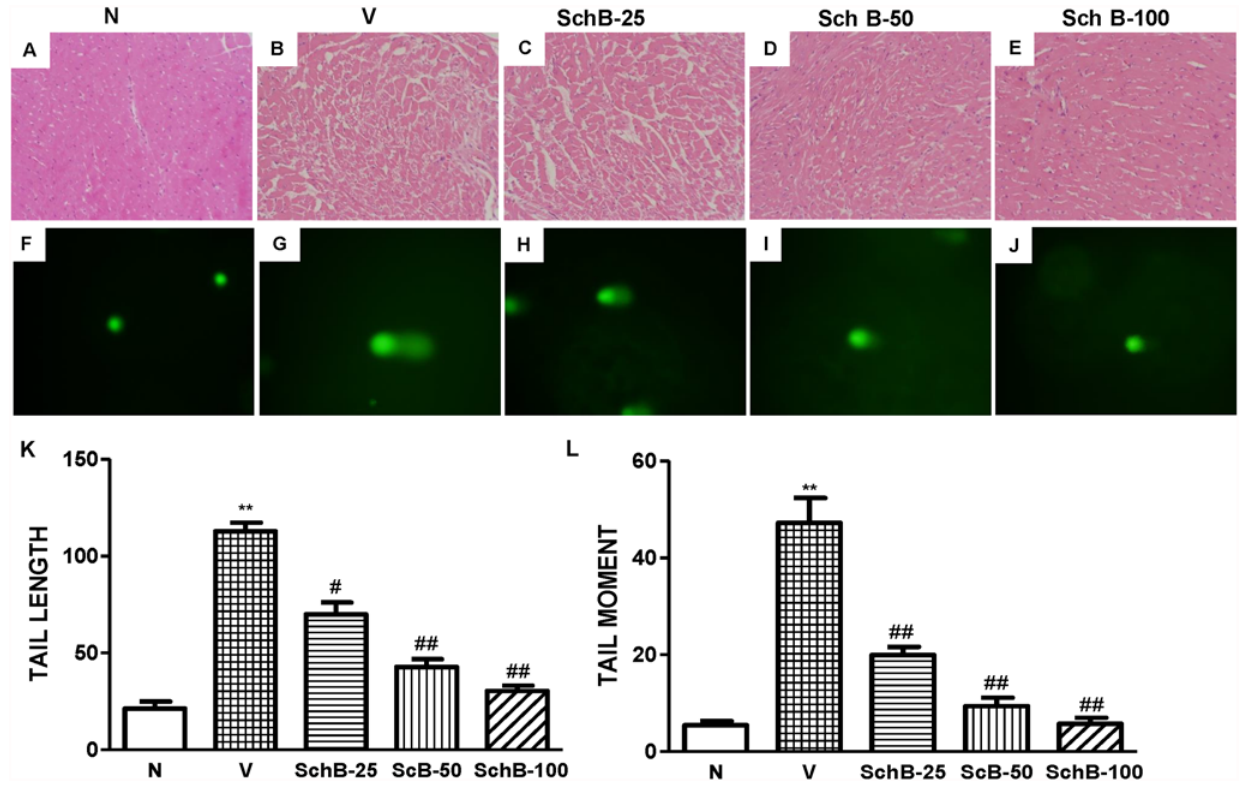
Fig 2. Sch B suppressed the cardiac morphological changes and DNA damage. Typical photomicrographs of heart tissue from group N (A), group V (B) and group Sch B (C – E). Cytoplasmic vacuolation and myofibrillar disorganization in the doxorubicin group were effectively attenuated Sch B treatment (haematoxylin and eosin ×200). (F – J) Representative photomicrographs of DNA damage 5 days after Dox injection. DNA damage detected by single cell gel electrophoresis assay (Comet assay) in cardiomyoctes of all groups at 200x magnification. (K – L) Quantification of cardiomyocyte DNA damage analyzed by digital imaging casp-software (http://casp.sourceforge.net/). ** P < 0.01 vs. group N mice; # P < 0.05 and ## P < 0.01 vs. group V